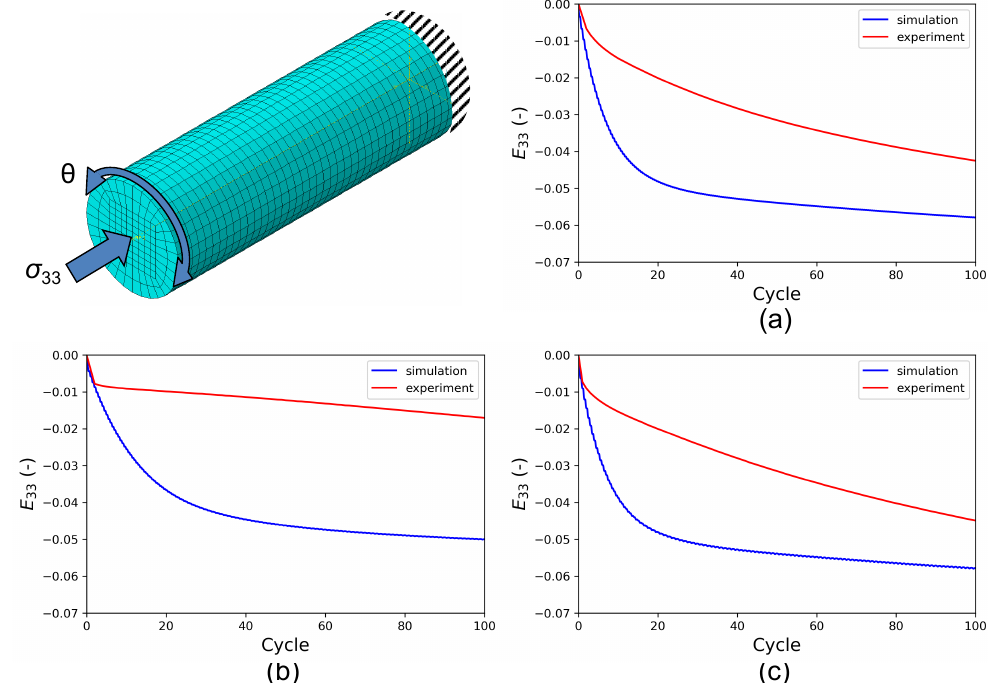
Figure 7. ( top left ) FE model used to simulate HTPF loading with a J2 plasticity model and resulting axial creep strain ( E 33 ) of simulation and experiment vs. cycle number. The axial pressure amounted to σ 33 = 250 MPa and three different combinations of amplitude ratios R and cyclic torsion amplitudes θ are shown: ( a ) R = − 1, θ = 7.5 ◦ , ( b ) R = 0, θ = 10 ◦ , and ( c ) R = 0, θ = 15 ◦